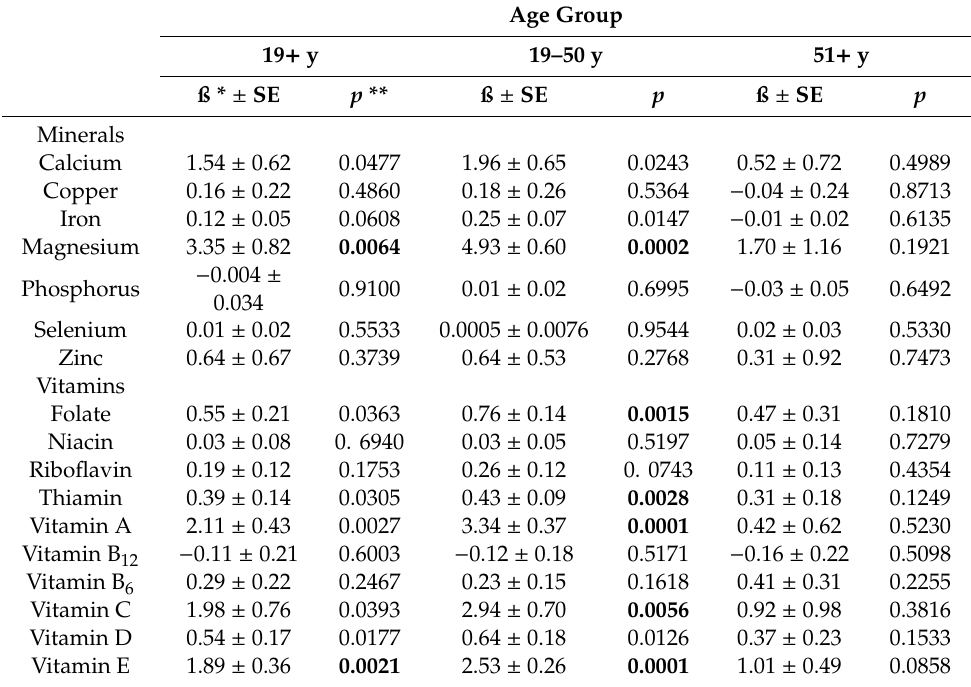
Table 3. Association between added sugars intake (% of calories) and percentage of adults 19 + y